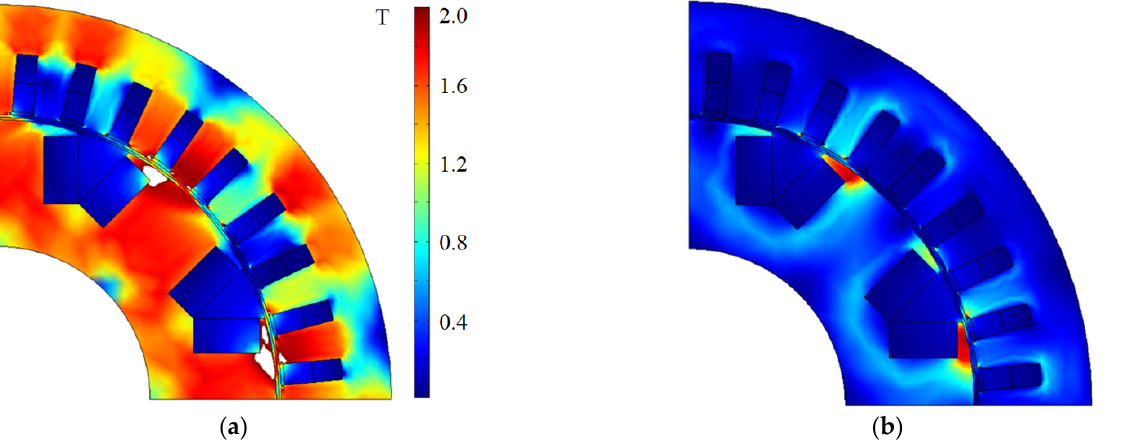
Figure 7. The optimized wound rotor synchronous motor cross ‐ section and the magnitude plot of flux density; white areas mark the extreme saturation level (>2 T): ( a ) loading point 3; ( b ) loading point 1.